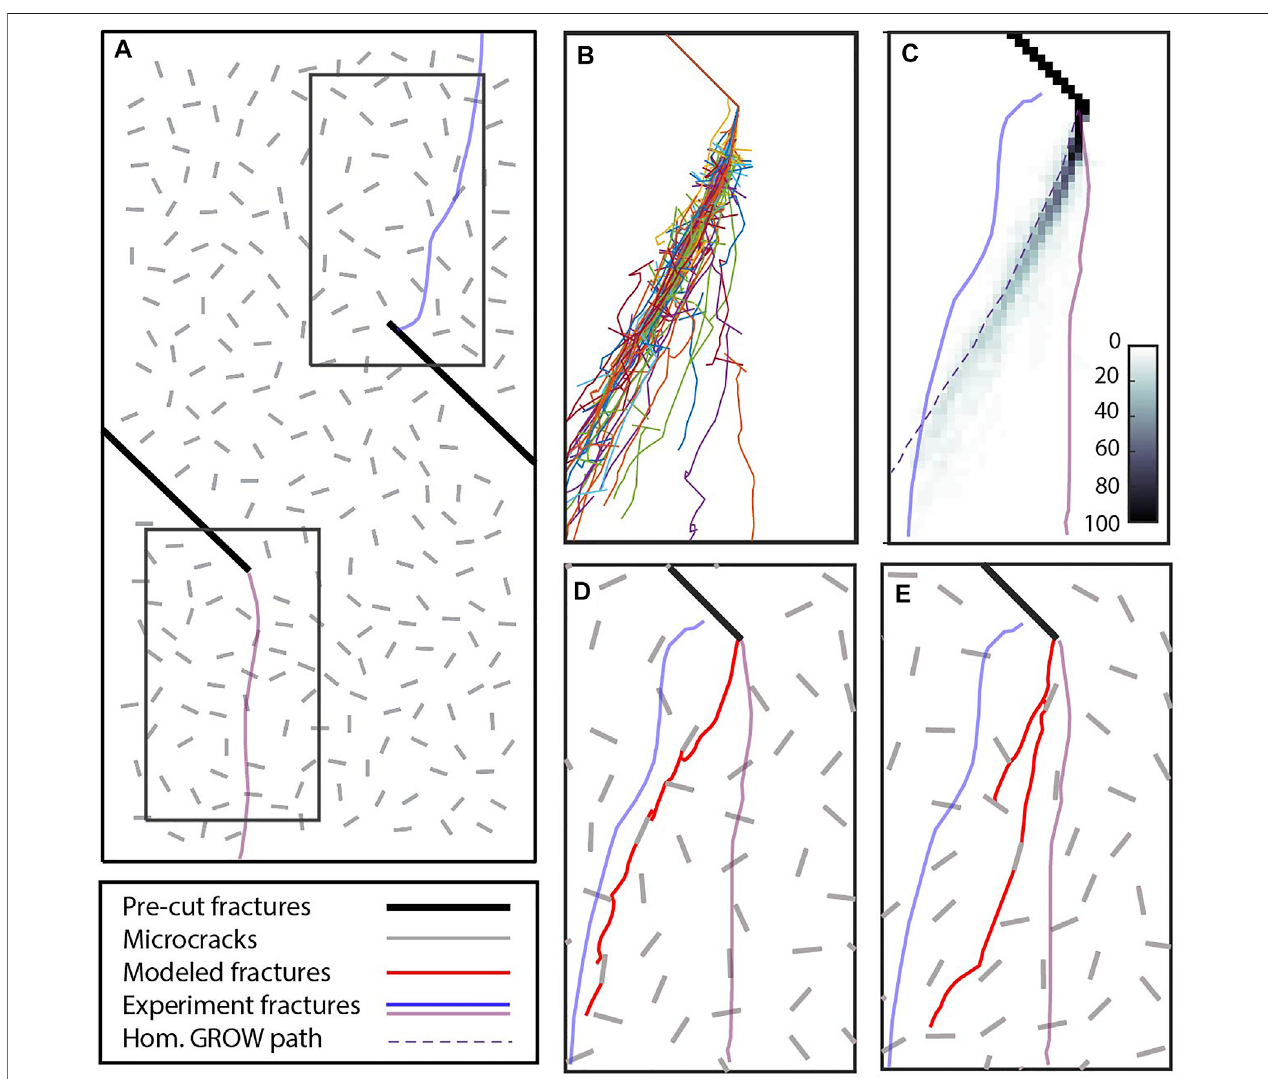
FIGURE8|(A) Modelincorporating250randomlyoriented2 mmmicrocracksrepresentinggrainboundaries. (B) Overlayofcrackpathsfrom100simulationswith variedrealizationsofmicrocracksdemonstratesthevariationandcomplexitythatarisefromtheincorporationofheterogeneity. (C) Griddeddensityofcracklinkagefrom 100 simulations to highlight range of crack paths from the tip of the preexisting crack. Paths observed in Yang et al. (2009) experiments from both pre-cut fractures are shown in blue and purple. A dashed line shows the homogeneous model crack path. (D) Example crack path following central preferred path. (E) Example crack path that closely matches the axial propagation path from lower crack tip of the Yang et al. (2009) experiment.